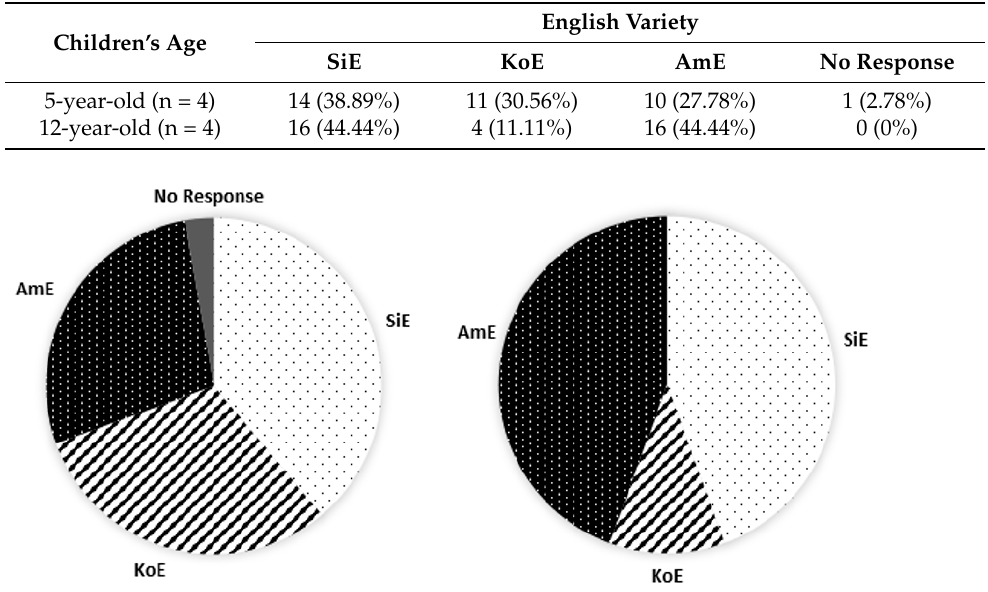
Figure 4. Percentage of 5 ‐ year ‐ old ( left ) and 12 ‐ year ‐ old ( right ) children’s preference for SiE, KoE, and AmE.